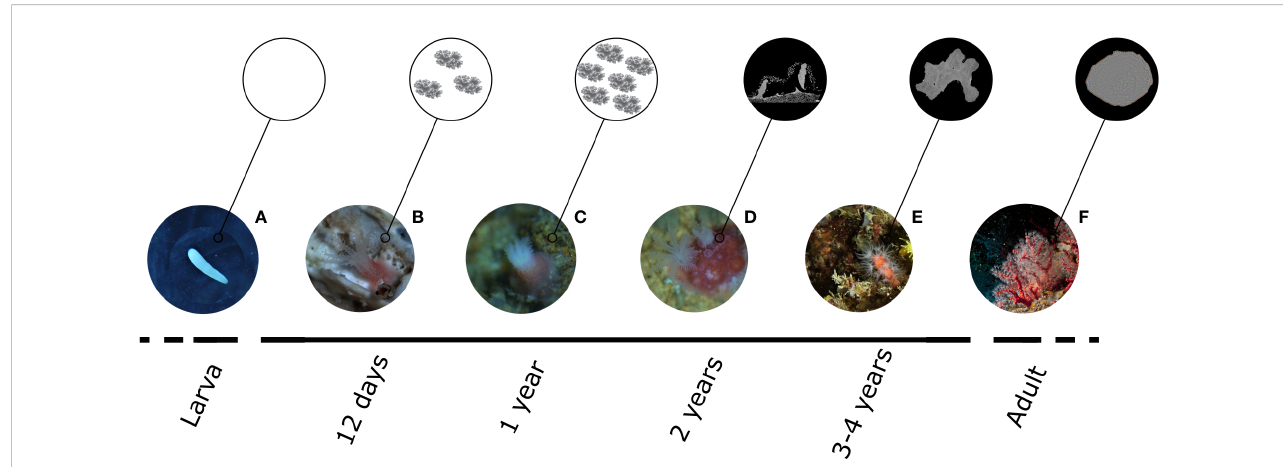
FIGURE 6 Summary of results describing the biomineralization process in C. rubrum , from larval to adult stage. (A) During the pelagic larval phase, no biomineral structures are present, and larvae are mainly composed of lipids. (B) Sclerites start to be produced during the fi rst days after settlement and are detectable in 12-day-old recruits for the fi rst time. (C) During the fi rst year of life the only biomineral structure of the recruits is represented by sclerite which number and density increase all along the fi rst year after settlement. At this stage, no cemented skeleton is detectable. (D) The presence of an axial skeleton is observed for the fi rst time in 2-year-old recruits. (E) 3-4-year-old colonies do not show the presence of growth rings in the skeleton, meaning that the annular growth still does not occur. (F) The internal structure of the axial skeleton in adult clonies is organized in two distinct areas: a central medullar zone and a surrounding annular zone constituted by several concentric calcitic